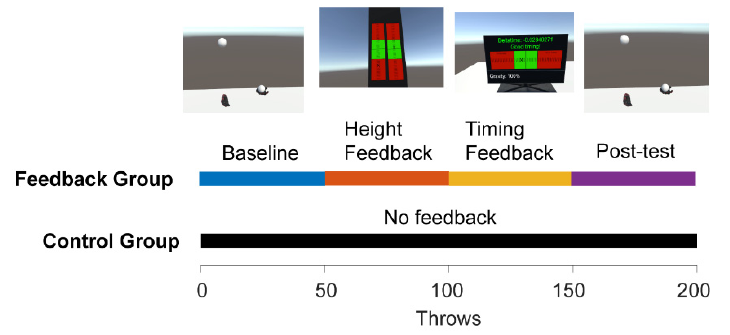
Figure 2. Training protocol. All participants first completed an initial practice phase in which participants got accustomed to the VR environment and learned to throw and catch one ball. Next, all participants completed 50 throws with two balls. After these 50 throws, the feedback group received height feedback on the next 50 trials and then timing feedback on the next 50 trials. The control group simply continued to practice without any quantitative input. The session finished with another 50 throws in which no feedback was given. See Figure 1 for larger versions of the screenshots.